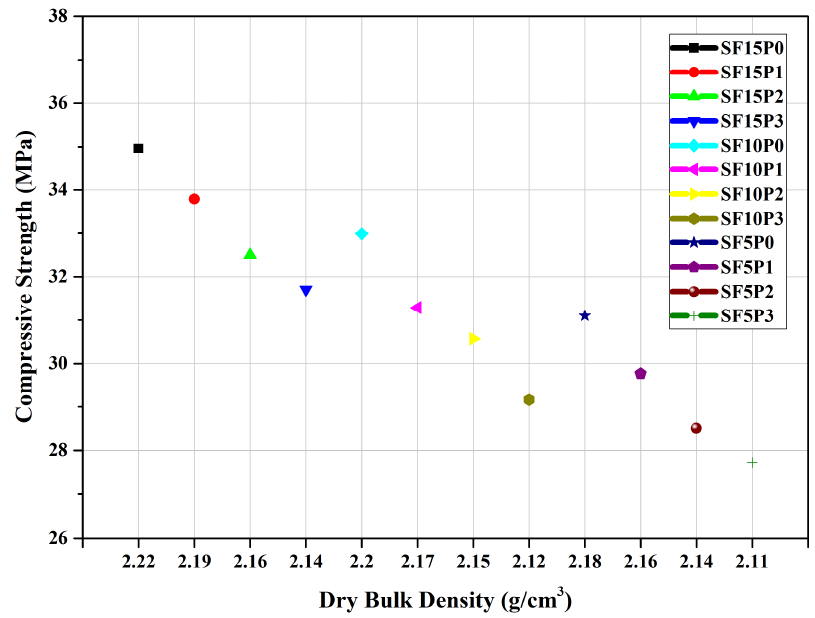
Figure 19. Relationship between compressive strength and dry bulk density of the SF samples.